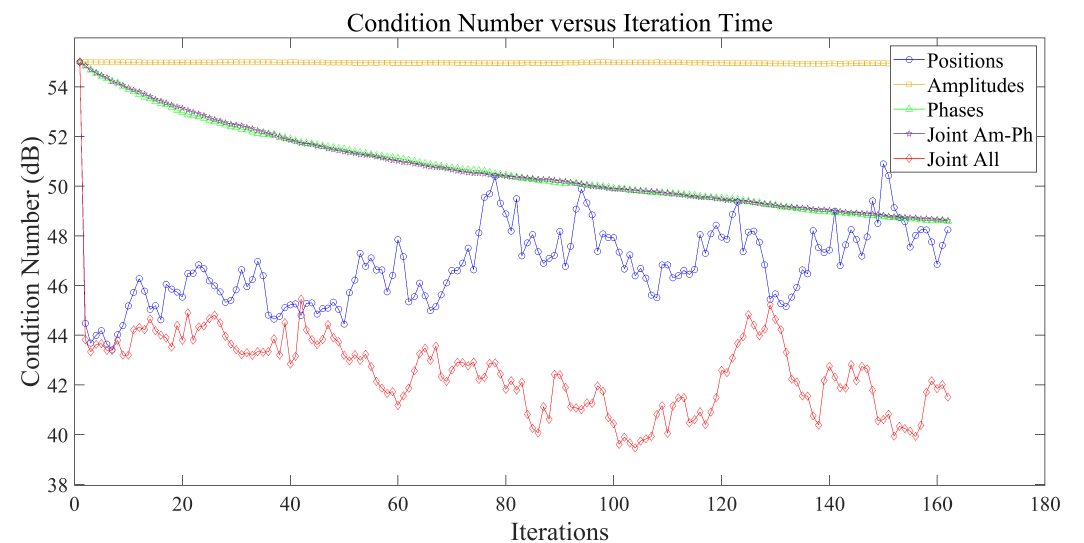
Figure 12. The iteration procedure of condition number versus diverse optimizing